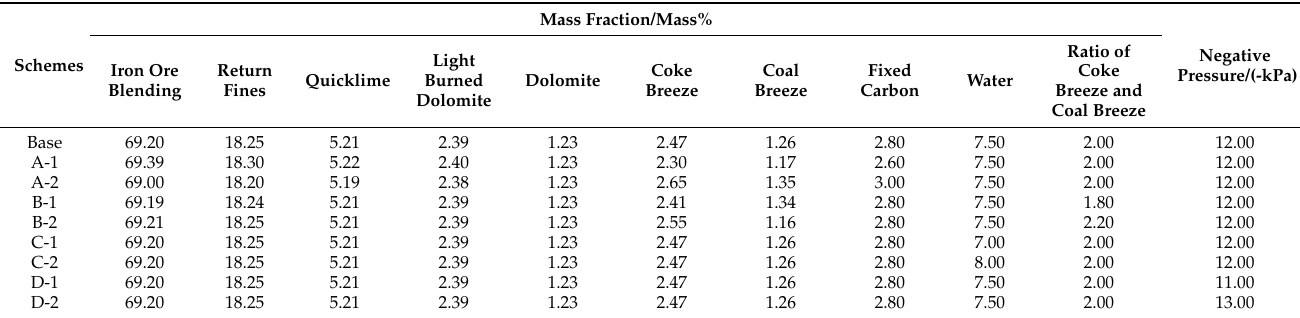
Table 4. Proportions of raw materials in sintering mixture, the ratio of CTC, and negative pressure at different